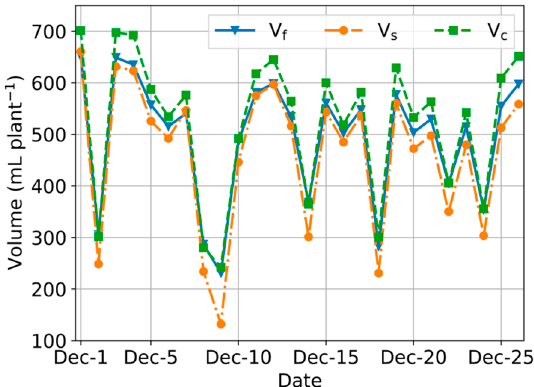
Figure 6. Tomato daily water requirements calculated according to different solar radiation estimation methods during experimental period, and water requirement computed according to data collected from sensors inside the greenhouse.